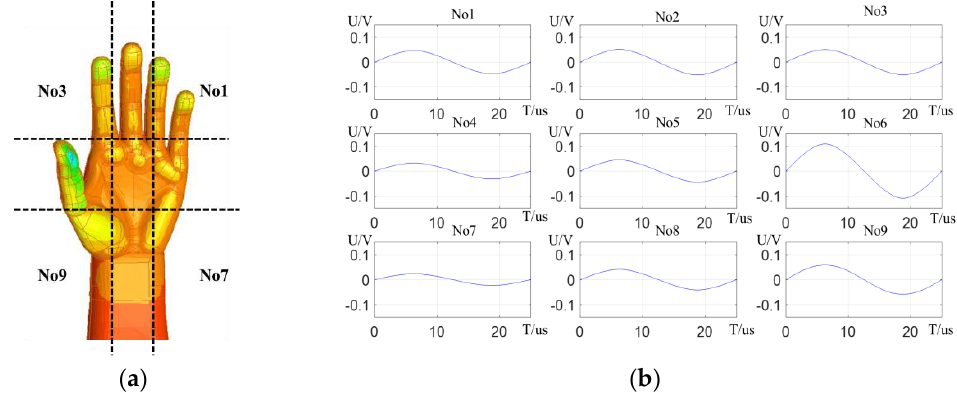
Figure 6. Simulation Analysis of Stretched hand: (a) Simulation model of Stretched hand; (b) Sensing